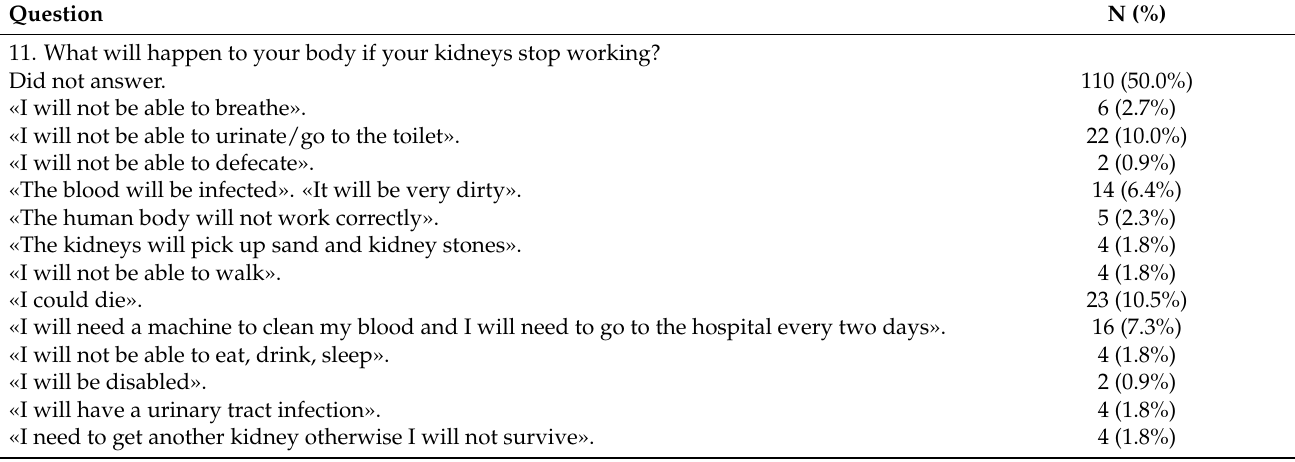
Table 2. Consequences for kidney malfunction.